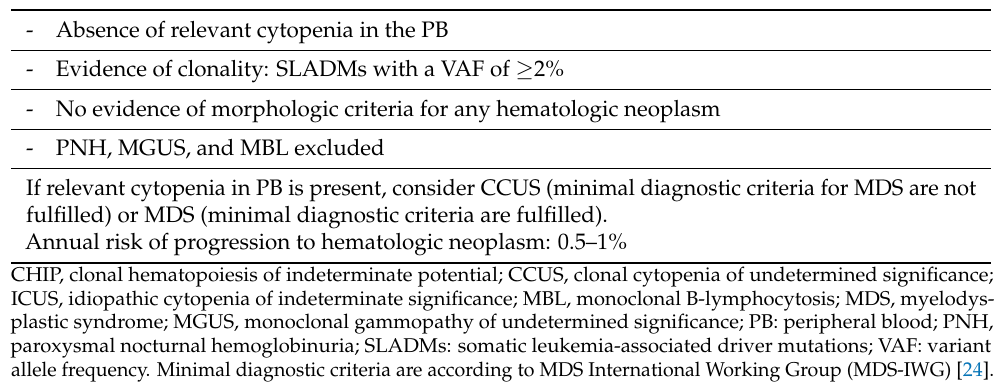
Figure 1. Factors involved in clonal evolution (adapted from [16]). CHIP: clonal hematopoiesis of indeterminate potential; MDS: myelodysplastic syndromes; sAML: secondary AML; CTX: chemotherapy; RT: radiotherapy. Adapted from [23]. Table 2. Definition of